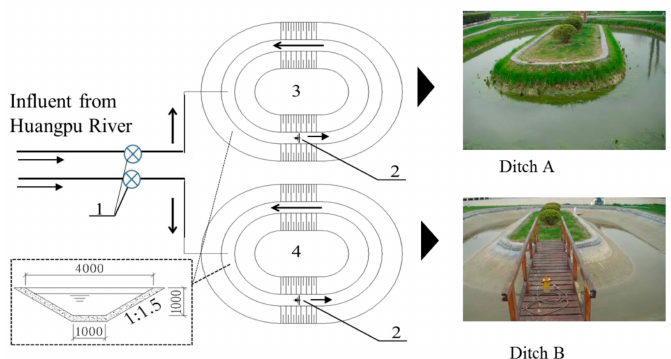
Figure 1. Flow chart and structure of modeling experimental setup. Arrow indicates water flow direction. The cross section of ditch is in the dotted box (unit: mm). 1, water pumps; 2, water propellers; 3, experimental group (Ditch A); 4, control group (Ditch